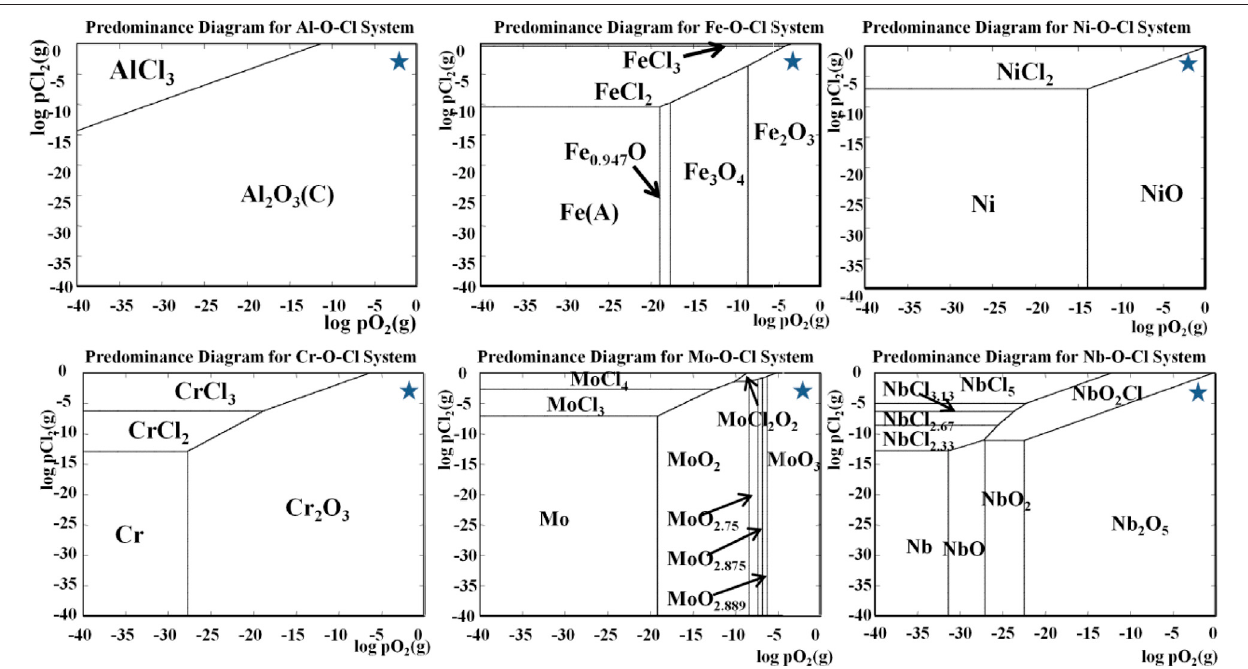
FIGURE13| ThermodynamicstabilitydiagramsofthesystemsNb – O – Cl,Fe – O – Cl,Al – O – Cl,Ni – O – Cl,Mo – O – Cl,andCr – O – Clat800 ° C.ThepartialpressureofO 2 and HCl used in this study had been marked by “ * ”